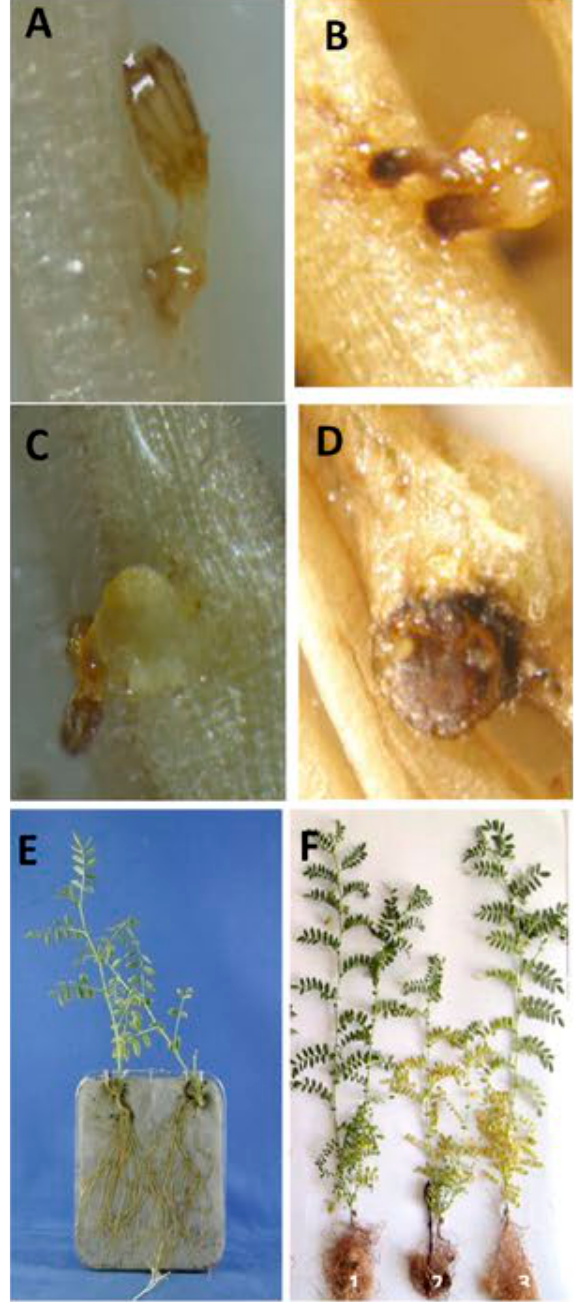
Figure 1. (A) typical germination, (B) seed germination with browning symptoms, (C) healthy tubercle fixed on chickpea roots, (D) tubercle with necrotic symptoms, (E) co-culture system using Petri dishes, and (F) plant grow- ing in pots (1: chickpea plant infested with O. foetida and inoculated with Rhizobium strain PchAZM, 2: chickpea infested with Orobanche and 3: healthy chickpea